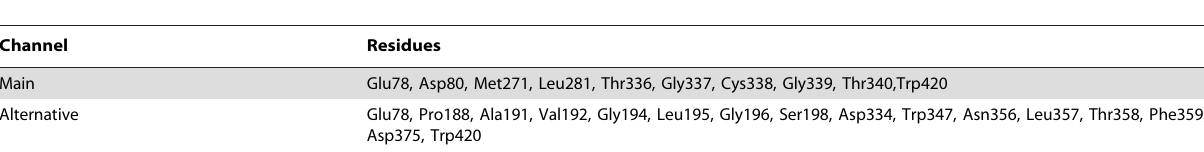
Table 2. Residues constituting the main and alternative channels in